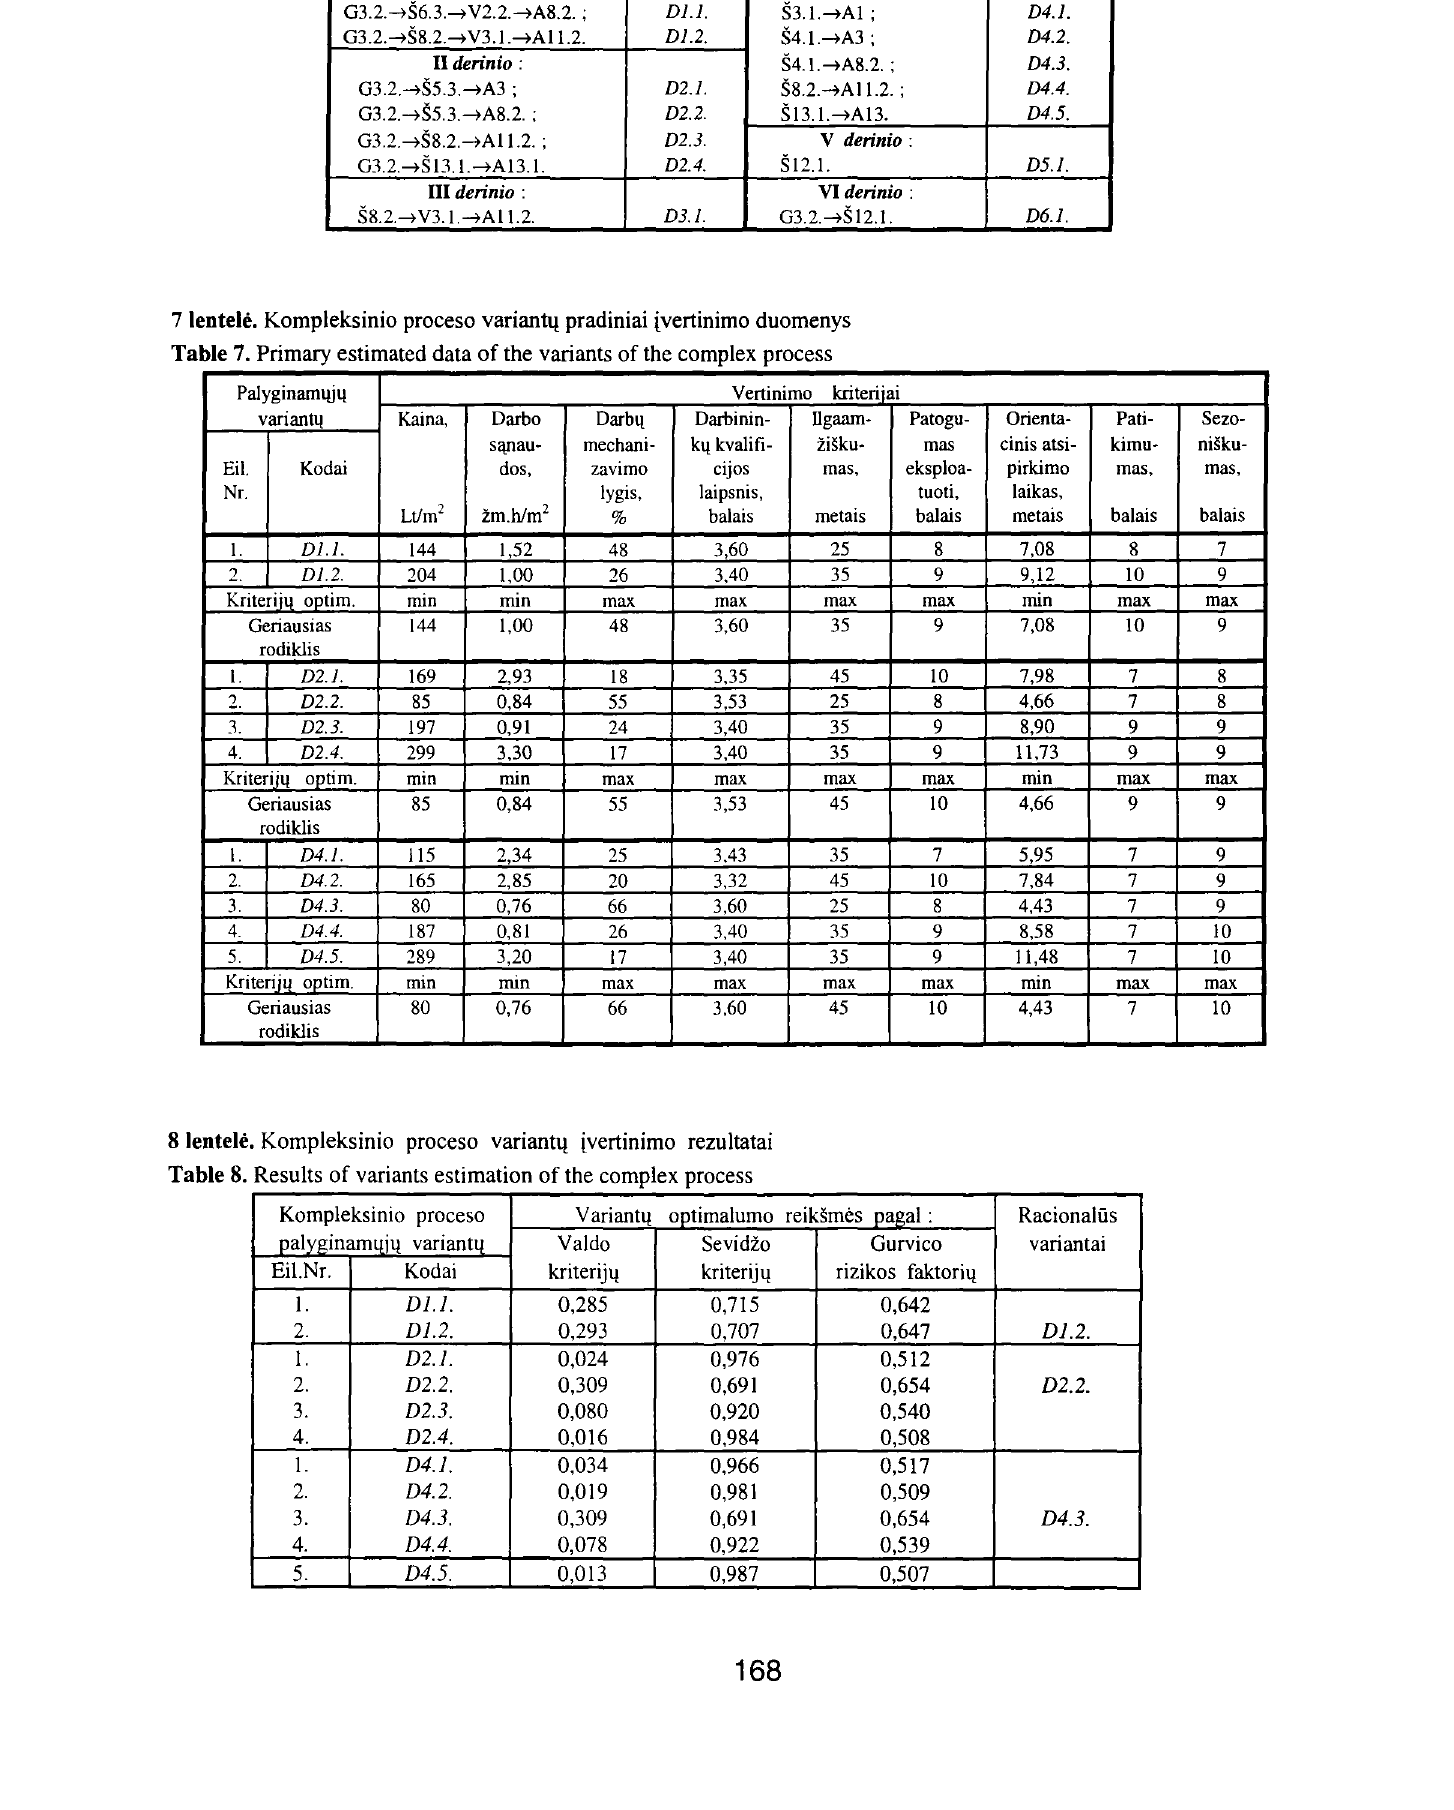
Table 6. Variants of combination of the walls isulation complex process Kompleksinio proceso Varianto